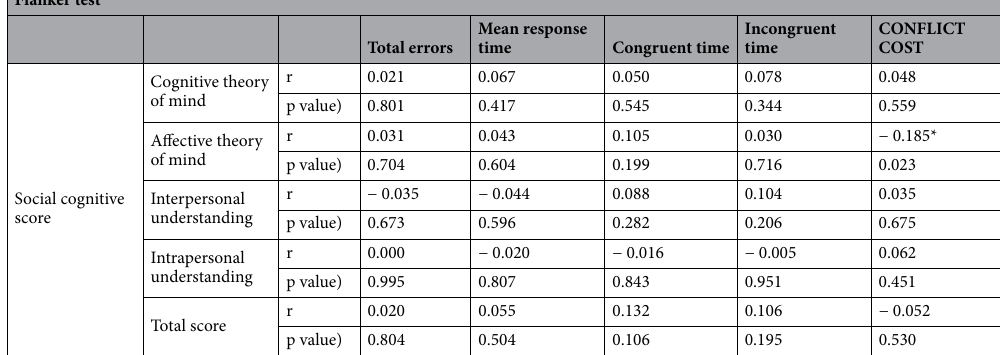
Table 6. Correlation between flanker test and Social cognitive score. r: Speraman correlation coefficient. *, **Statistically significant.